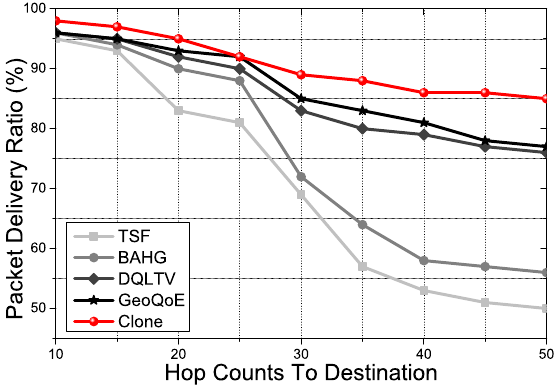
Figure 6. Packet delivery ratio for hop counts to the